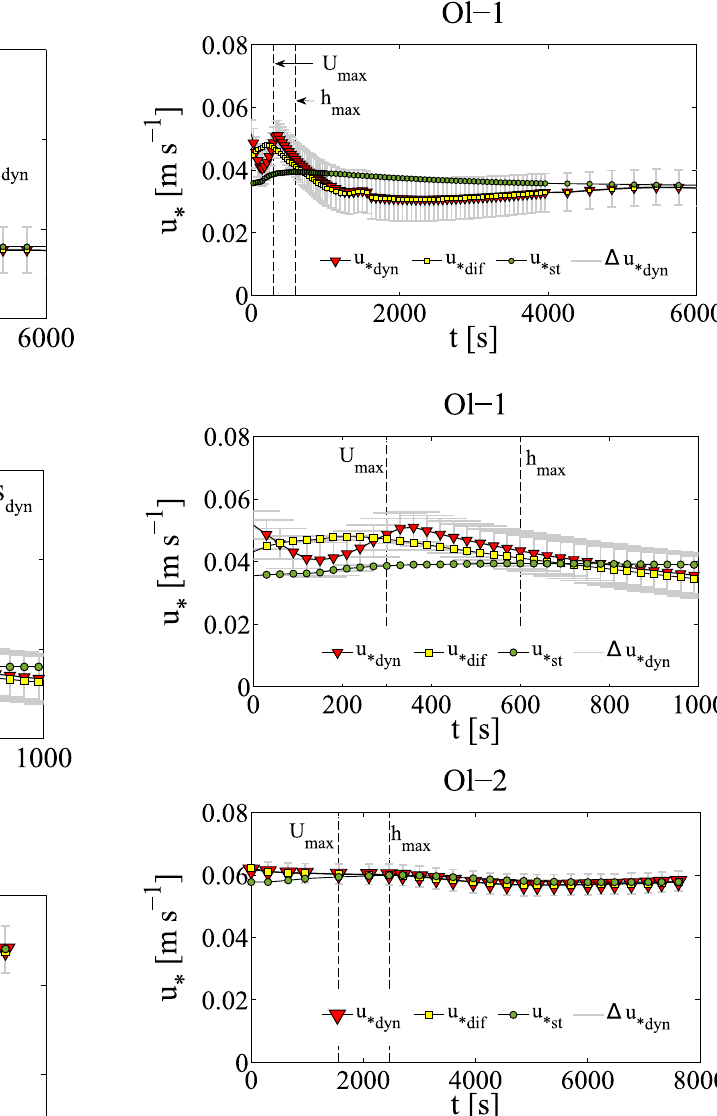
Figure 10. Comparison of friction velocity evaluated by formulae for dynamic u ∗ dyn , diffusive wave u ∗ dif and steady uniform flow u ∗ st with uncertainty bounds (cid:49)u ∗ dyn for experimental flood waves in the Olszanka watercourse. Middle panel shows an enlargement of the rising limb of the wave for